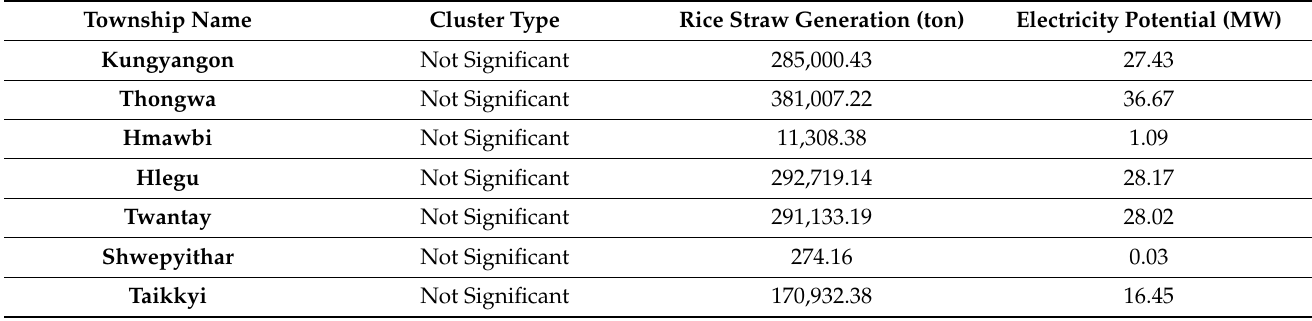
Figure 6. Township-based clusters for rice straw. Table 2. The Results of Township-Based Clusters Analysis of the Feedstock of the Rice Straw. Township Name